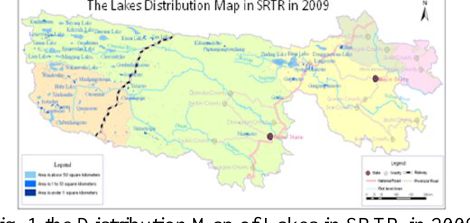
Fig .1 the Distribution Map of Lakes in SRTR in 2009 Tab.1 the Statistics of the Lakes in SRTR in 2009